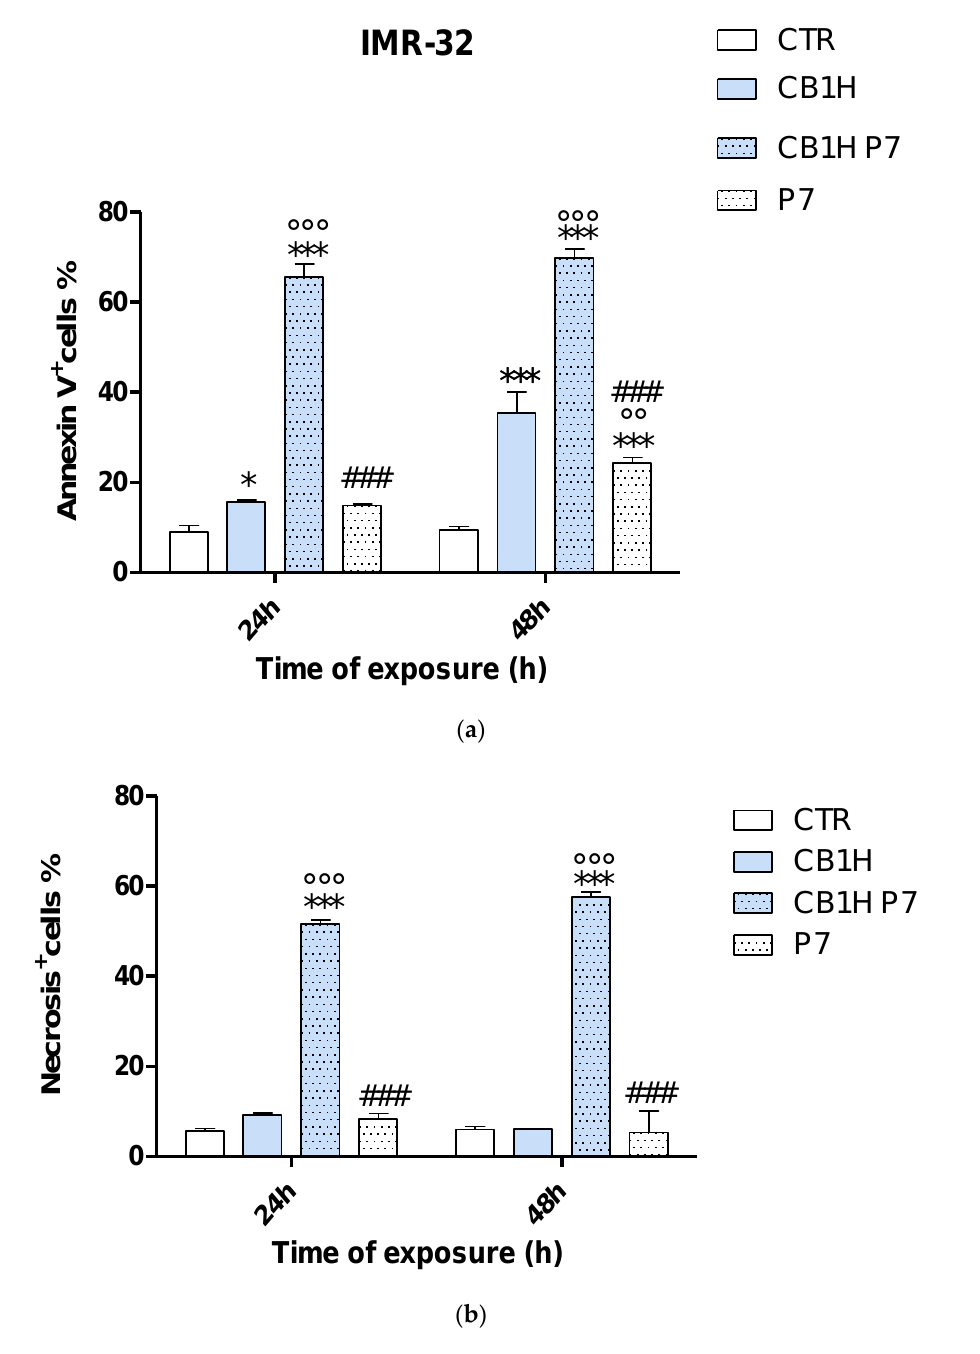
Figure 5. Time-dependent analysis of population of the IMR-32 cells with early-stage apoptosis ( a ) and with late-stage apoptosis/necrosis ( b ) detected by Annexin-V ( a ) and 4-AAD ( b ) staining. IMR-32 cells were grown in the presence or absence (CTR) of CB1H 20 µM, P7 0.57 µM and CB1H-P7 0.57 µM for 24 h and 48 h. Significance refers to control (*), CB1H (°), or CB1H-P7 (#). Specifically, p > 0.05 ns; p < 0.05 * (vs. CTR), ° (vs. CB1H), # (vs. CB1H-P7); p < 0.01 ** (vs. CTR), °° (vs. CB1H), ## (vs. CB1H-P7); p < 0.001 *** (vs. CTR), °°° (vs. CB1H, ### (vs. CB1H-P7).